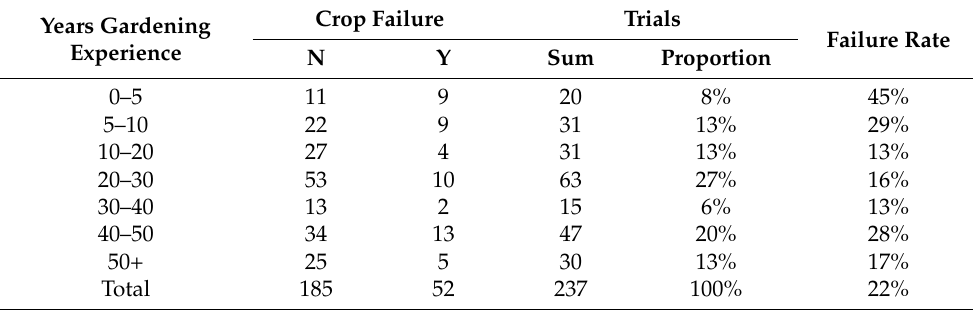
Table 7. Crop failure rate (N = no, Y = yes) by participant’s years of gardening experience as self- reported by trial participants in 2019 and 2020. Categorical analysis of crop failure by years of gardening experience was significant at an alpha level of 0.1 ( p = 0.0795).